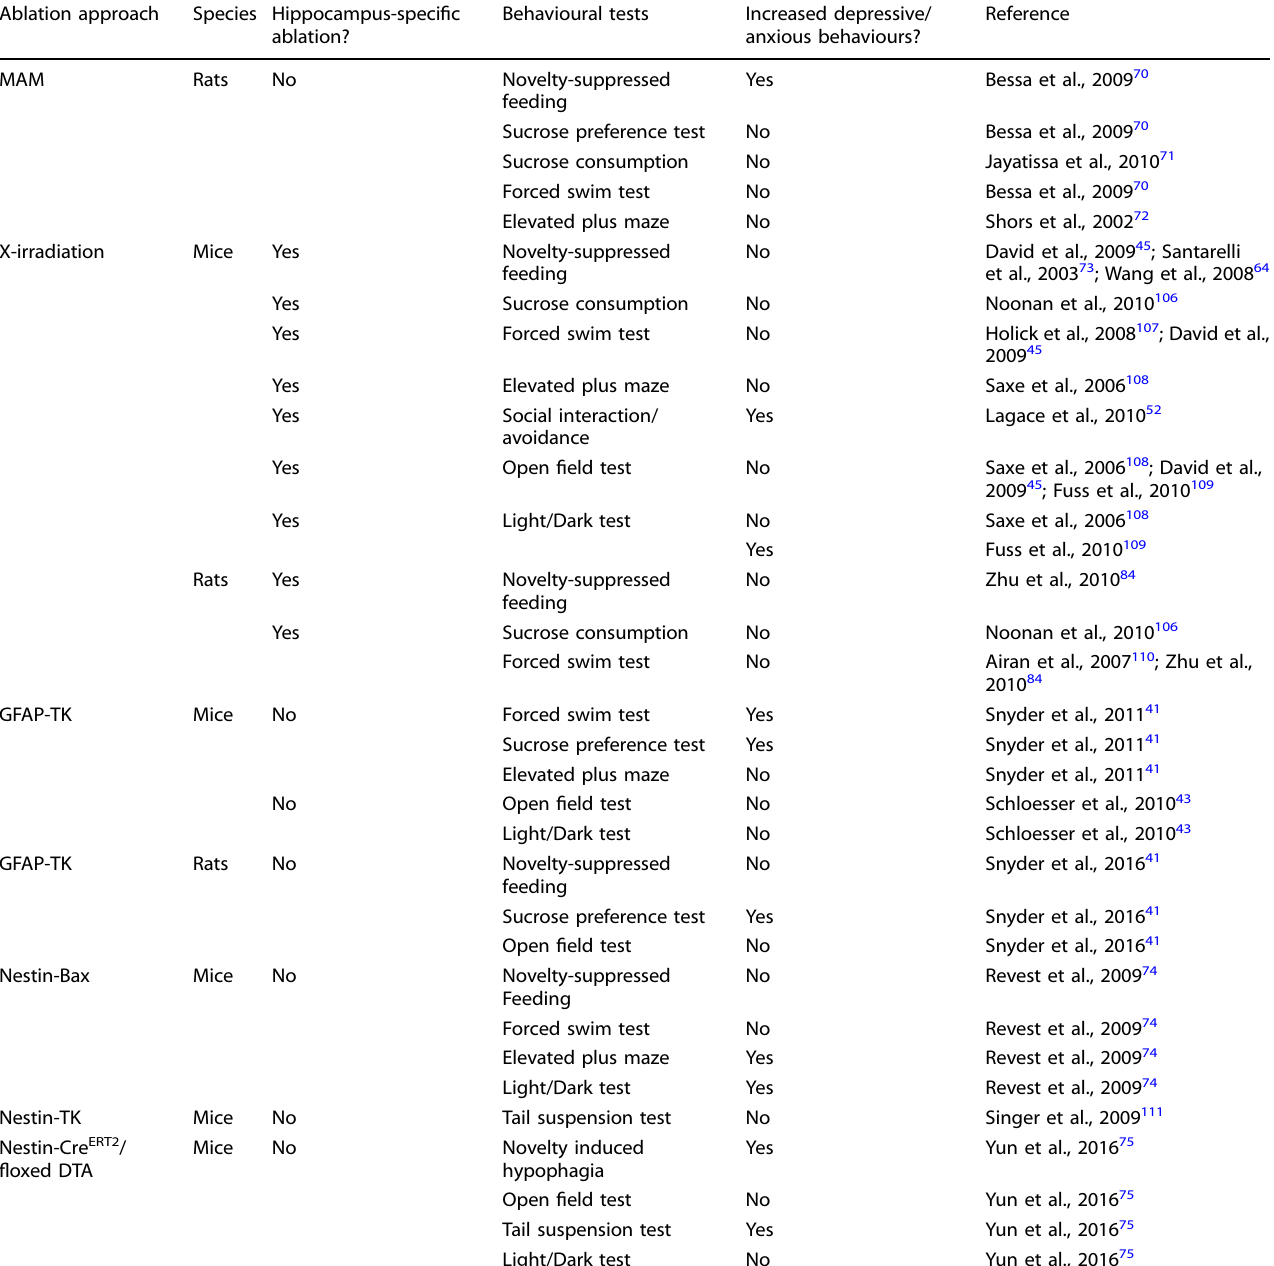
Table 1. Effects of ablating adult neurogenesis on mood-related behaviours in naïve, non-stressed